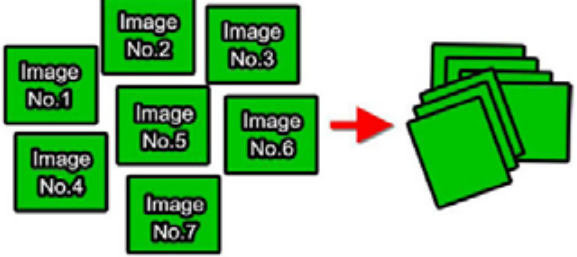
Figure 5. AFTP provides approximate image overlap information automatically